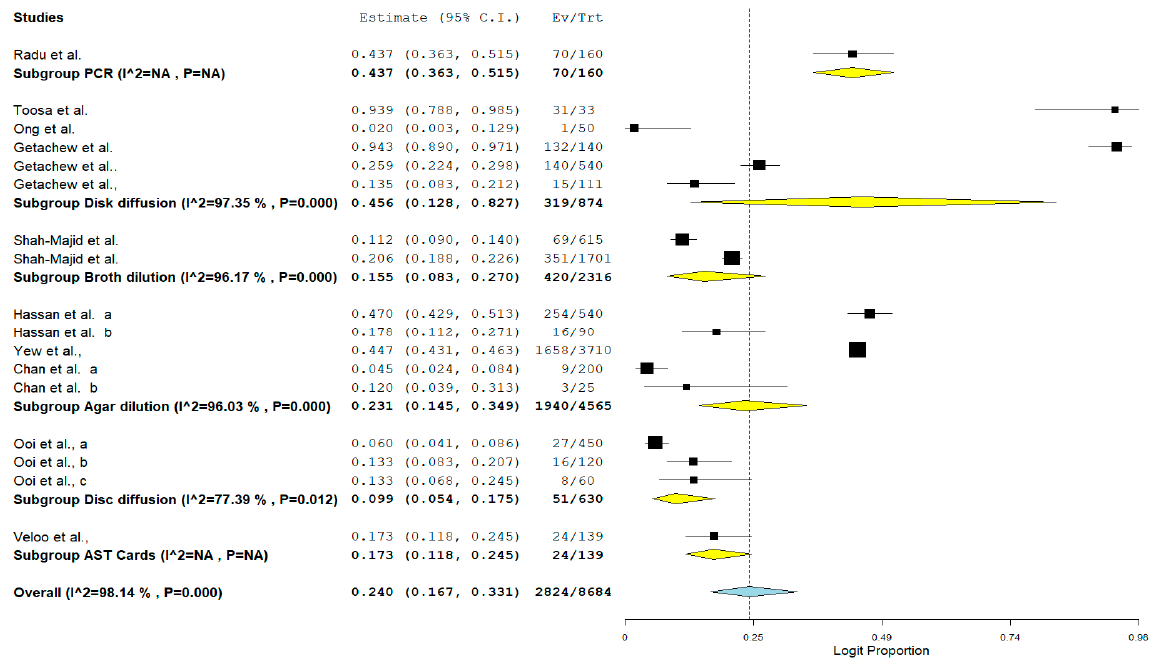
Figure 9. Forest plot showing the subgroup meta-analysis by detection method of VRE in poultry in Malaysia.